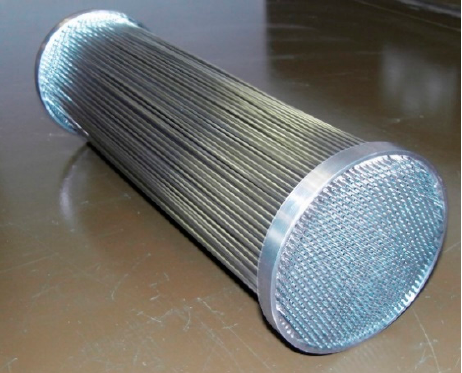
Figure 8. Heat exchanger core of ammonia / carbon heat pump generator [35].